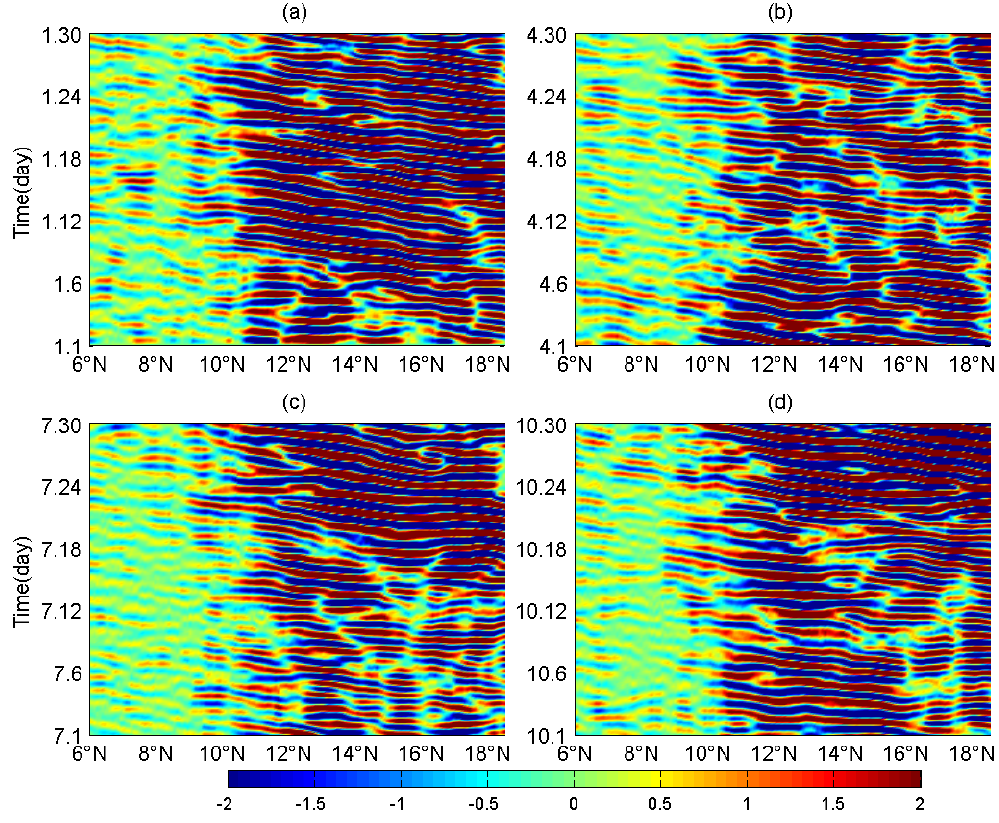
Figure 6. Time–latitude plot of 1–3-day band-passed SCSMOC signal at 1500m in (a) January, (b) April, (c) July, and (d) October in